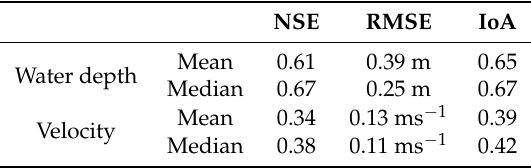
Table 2. Summary of model performance for cells containing water at the end of the simulation (Figure